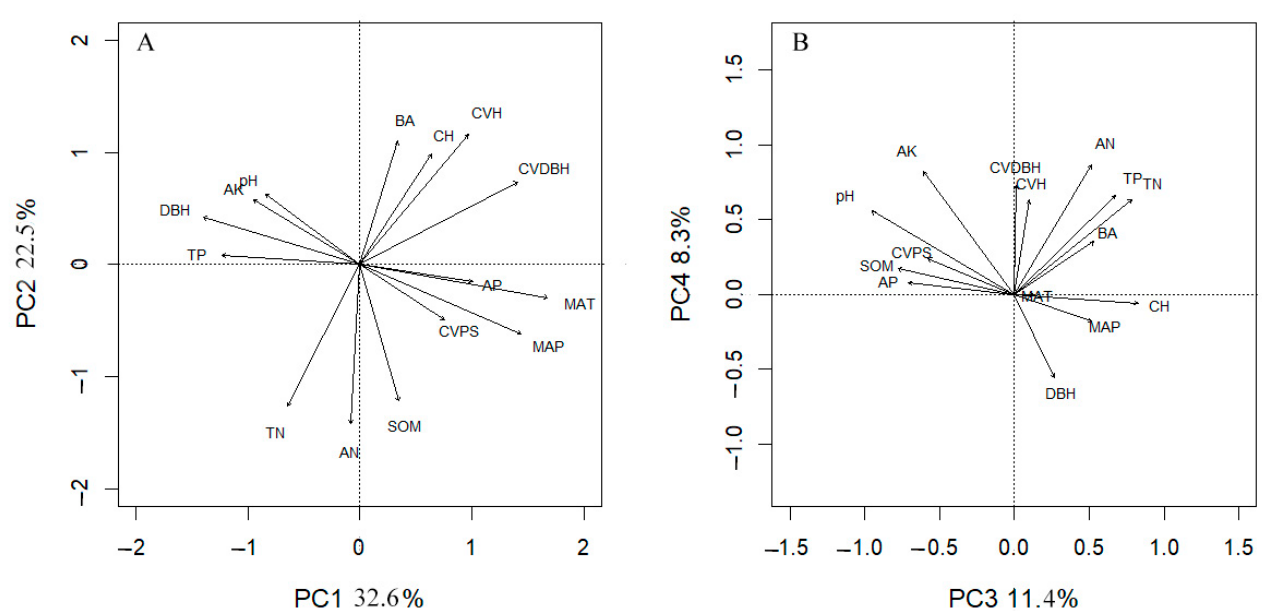
Figure 1. Loadings of biotic and abiotic factors of all forest plots on the first four principal components. The variable abbreviations are listed in Table 1. Note: ( A ) PC1 and PC2 of the compound habitat gradient axis; ( B ) PC3 and PC4 of the compound habitat gradient axis.